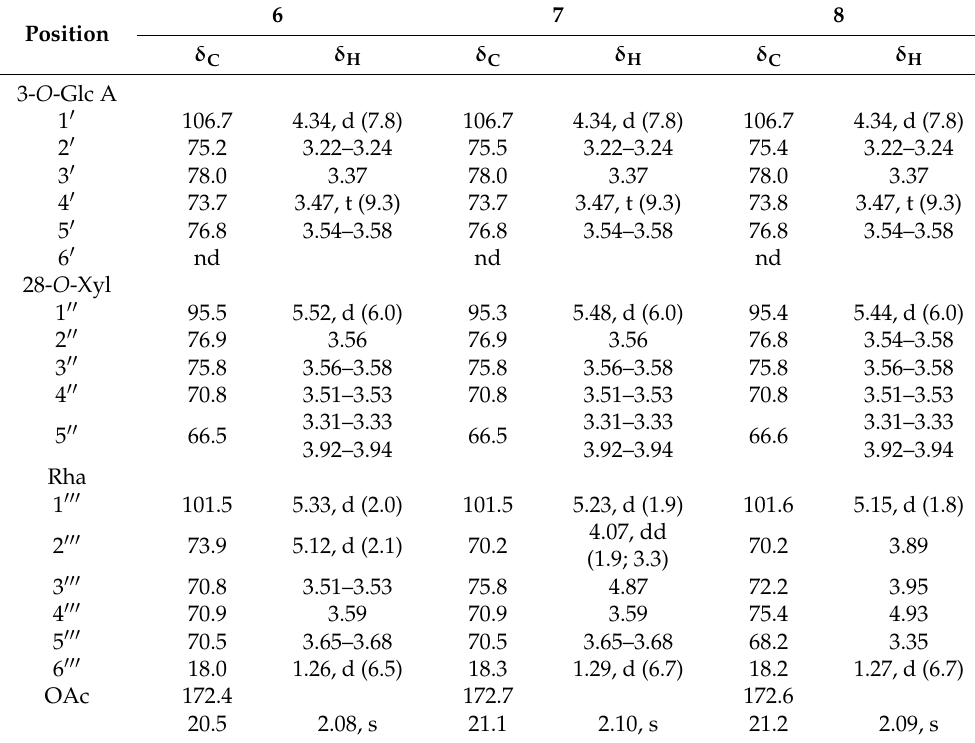
Table 5. 1 H and 13 C NMR data for the sugar moieties of 6–8 (800 and 200 MHz, CD 3